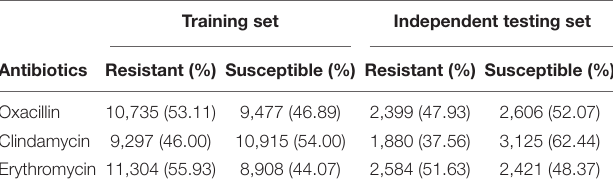
TABLE 1 | Number of data in training and independent testing sets. Training set Independent testing